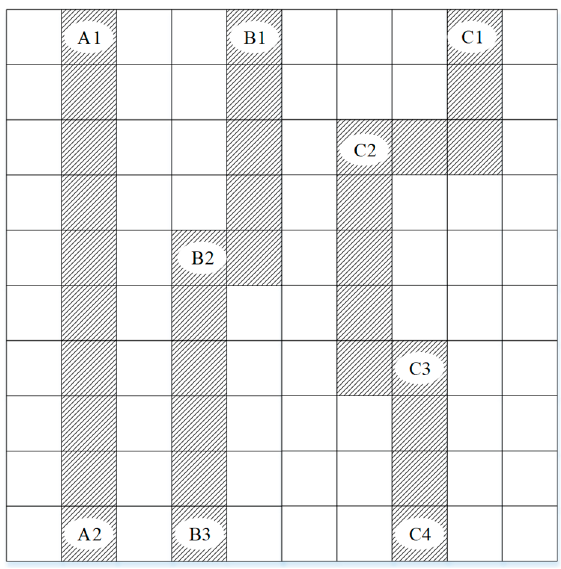
Figure 3. Schematic diagram of road (before compression).